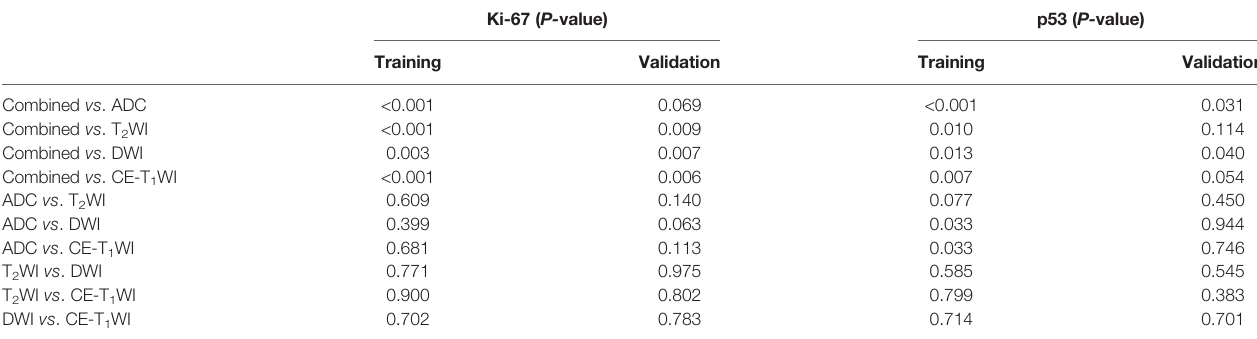
TABLE 6 | AUC of the fi ve models was compared.